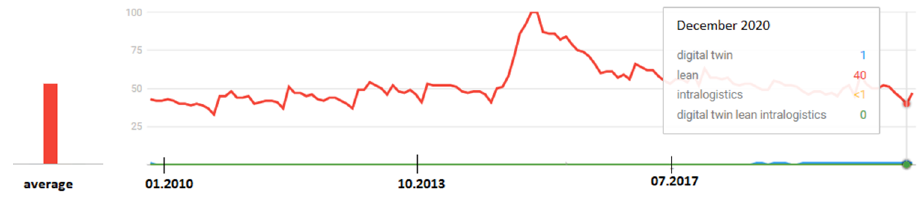
Figure 9. Global interest in the terms: digital twin + lean + intralogistics + digital twin lean intralo- gistics (concerns the period 1 Jan 2010–12 Jan 2021).